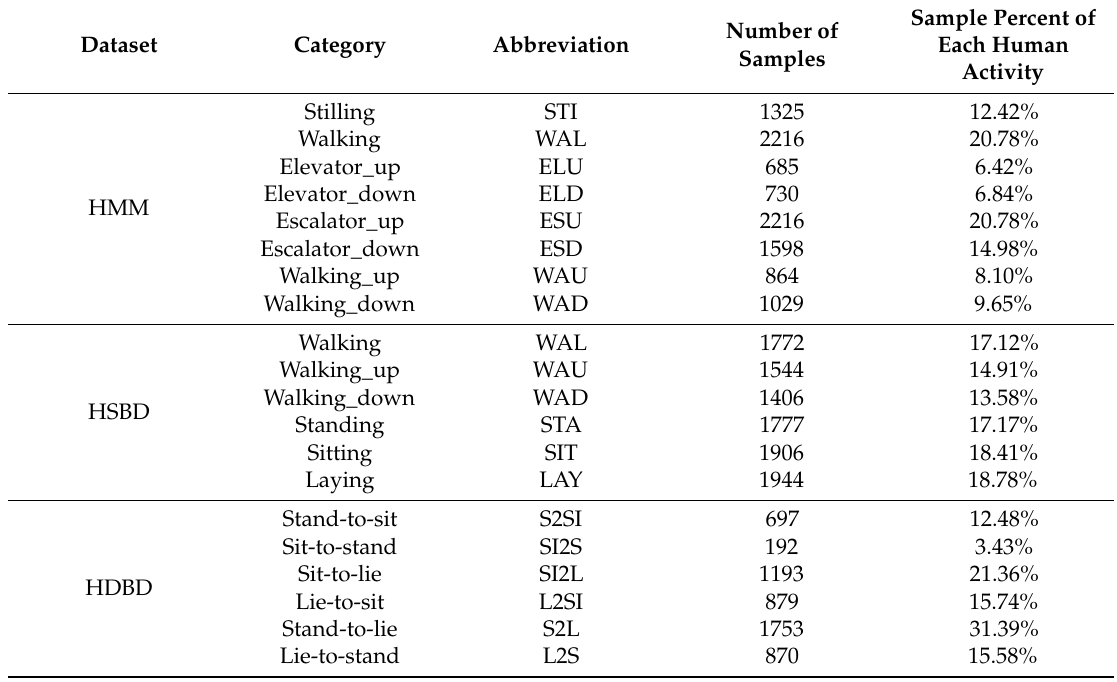
Table 6. The sample number of each category on each dataset. The HMM contains both HMMwithPre and